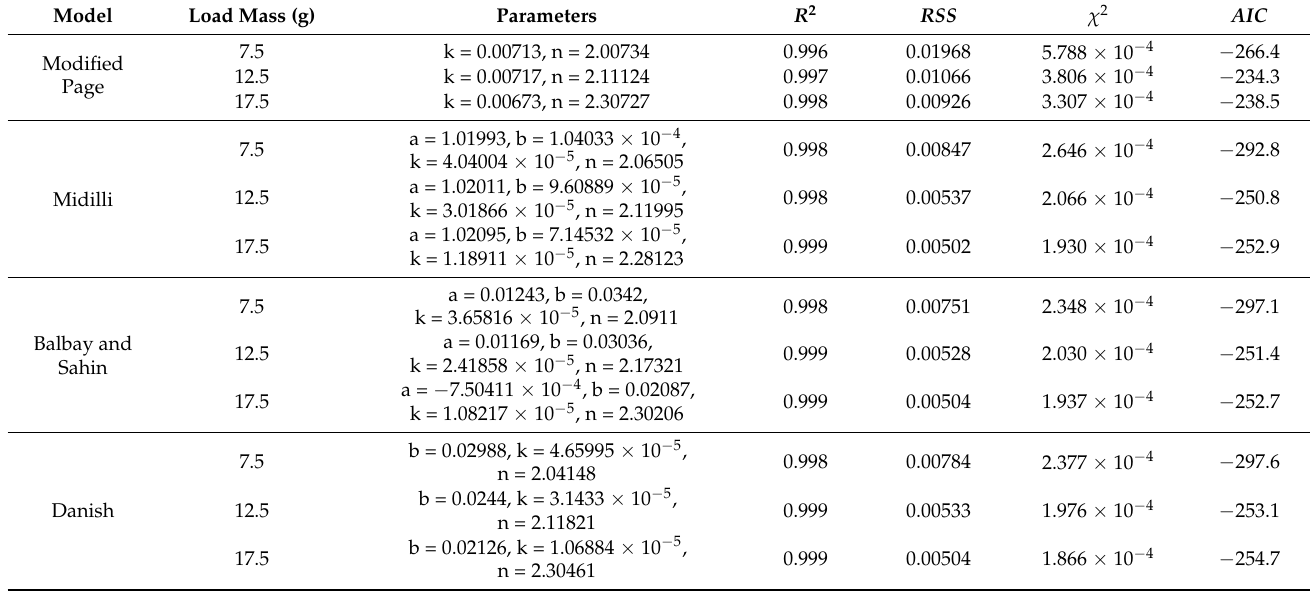
Table 7. Model fitting results of the microwave drying